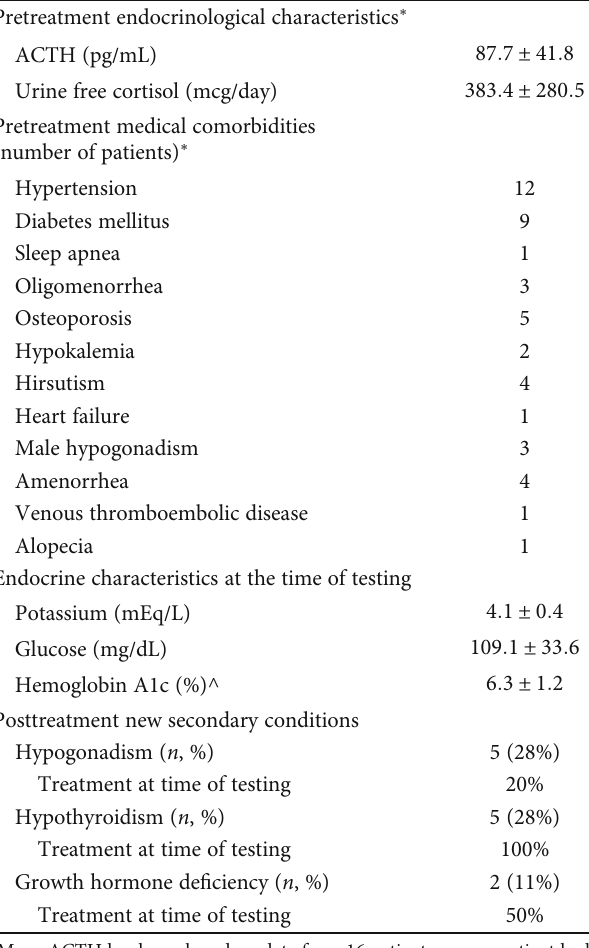
Table 1: Demographic, biochemical, and treatment details for Cushing ’ s disease at the time of neurocognitive evaluation.